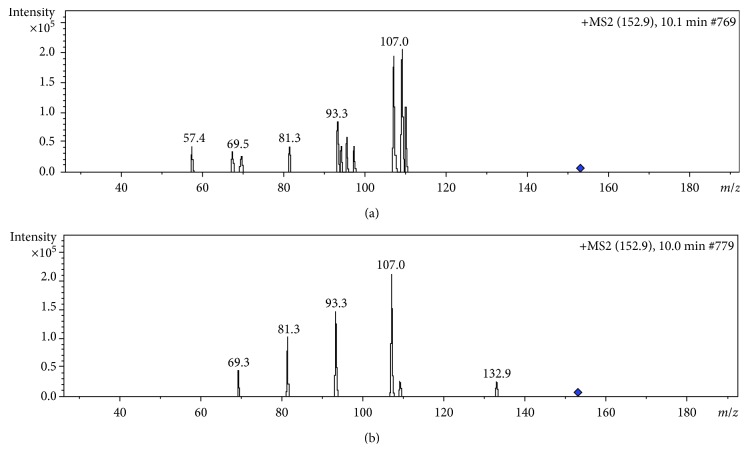
MS/MS spectra of sample (a) and pulegone (b).